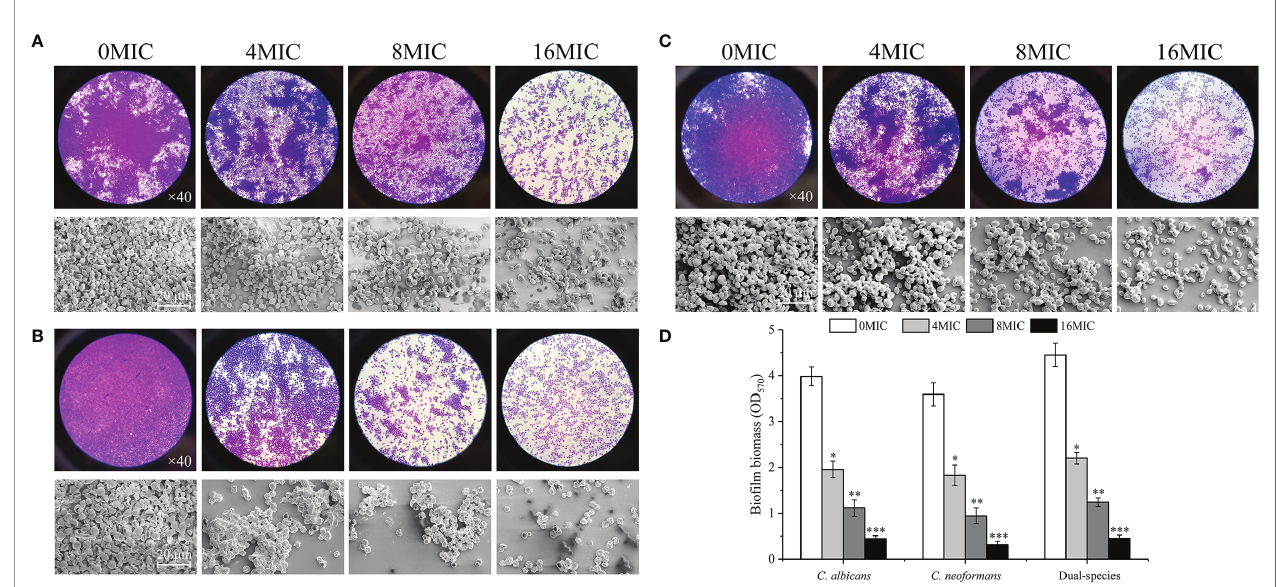
FIGURE 6 | Dispersal effects of paeonol on the preformed bio fi lm of C. albicans SC5314 (A) , C. neoformans H99 (B) , and dual-species (C) . (A – C) Preformed bio fi lms treated with various fi nal concentrations of paeonol ranging from 0 to 16 of the MIC were examined using the light microscope (objective lens, ×40) and fi eld emission scanning electron microscope (FESEM). (D) The changes of paeonol-treated preformed bio fi lms were examined using the crystal violet staining assay. Scale bars represent 20 m m. Bars represent the standard deviation ( n = 3). * p < 0.05; ** p < 0.01; *** p <